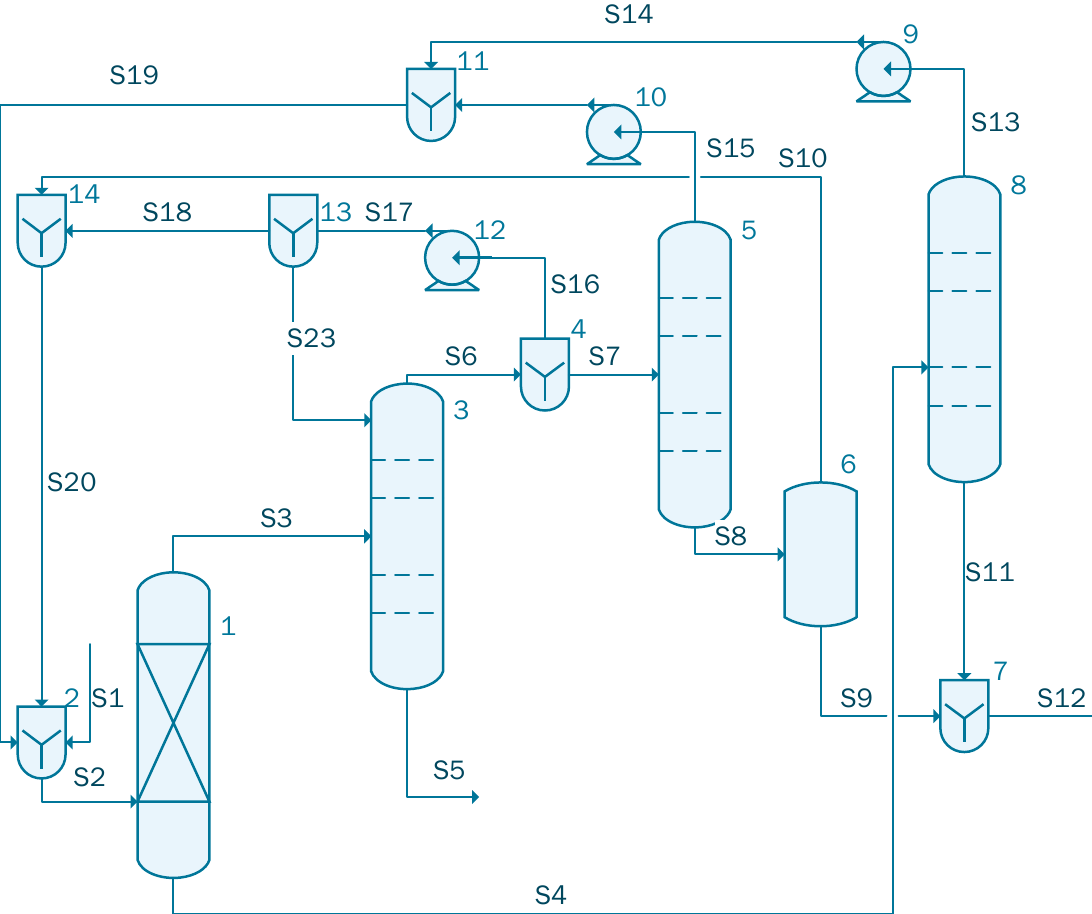
Figure 4. Process flow diagram for the acetic acid concentration process (case 2). The stream S1 containing 1000 kmol/h of acetic acid solution with the following component flow-rate: 861 kmol/h of Water and 139 kmol/h acetic acid is mixed in